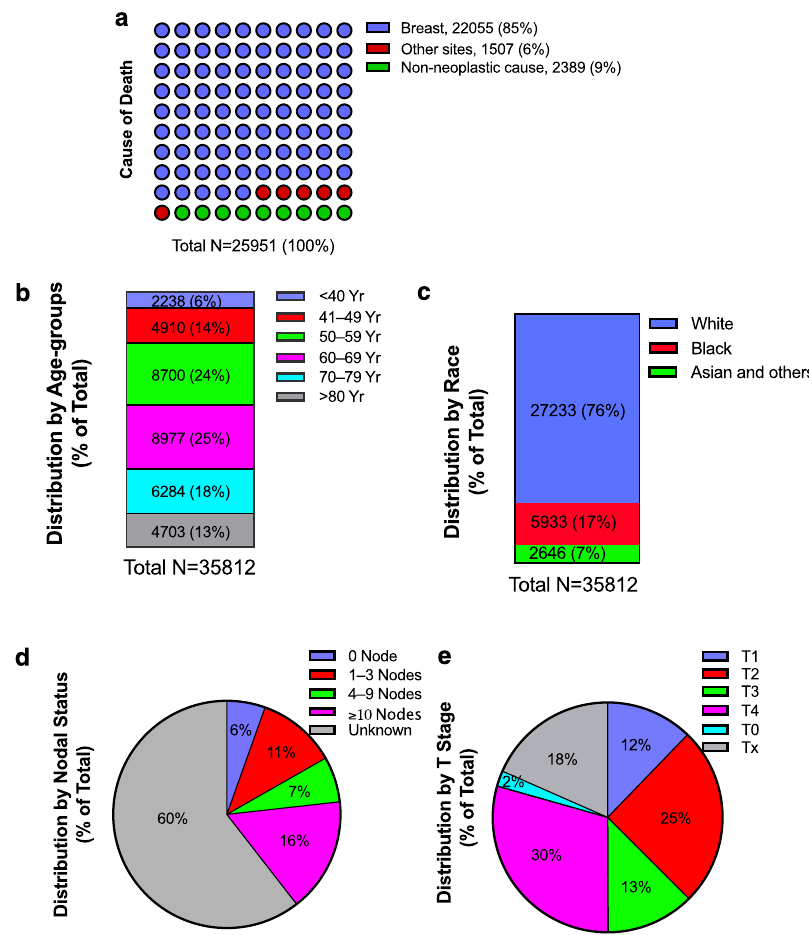
Fig. 1 Cause of death and distribution of de novo metastatic breast cancer by clinical factors in the United States. Shown were a , cause of death to site in the waf fl e chart; b , and c , number, and percentage of patients by age groups and race in the stacked bar chart; and d and e , distribution of the metastatic population by nodal status and T stages in the pie chart. N, number; Yr,